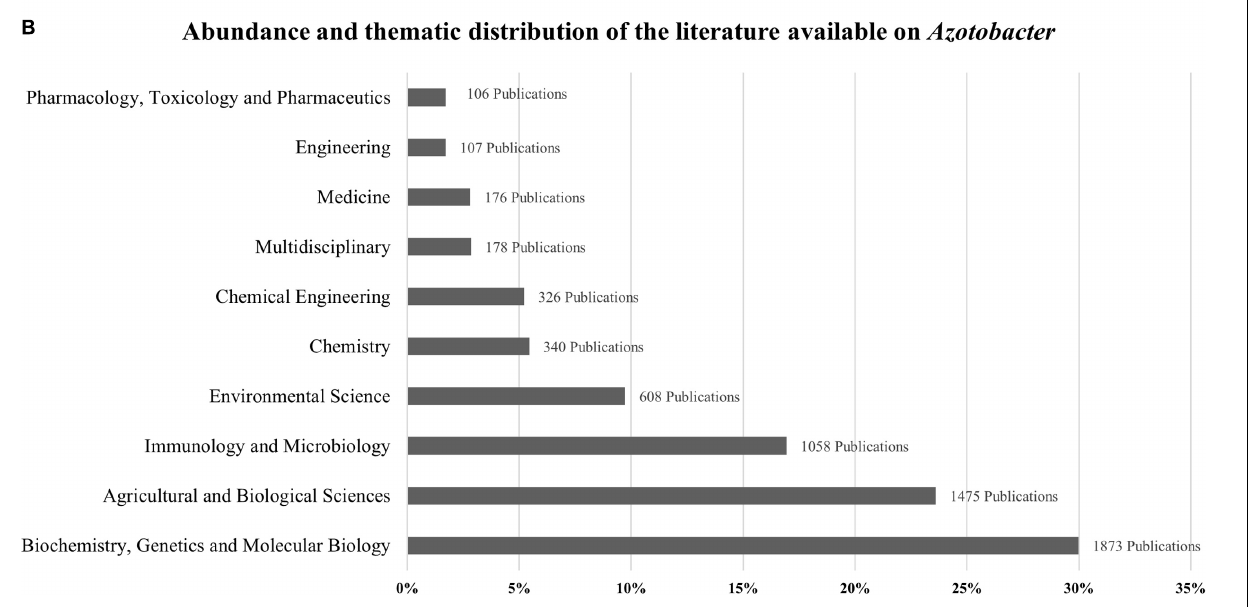
FIGURE 1 | (A) Exponential growth in the number of scientific publications related to Azotobacter from 1990 to 2020 using Azotobacter as a key word from scopus (https://www.scopus.com). (B) Abundance and thematic distribution of the literature available on Azotobacter . Bibliometric research made in scopus (https://www.scopus.com) using Azotobacter as a keyword in June